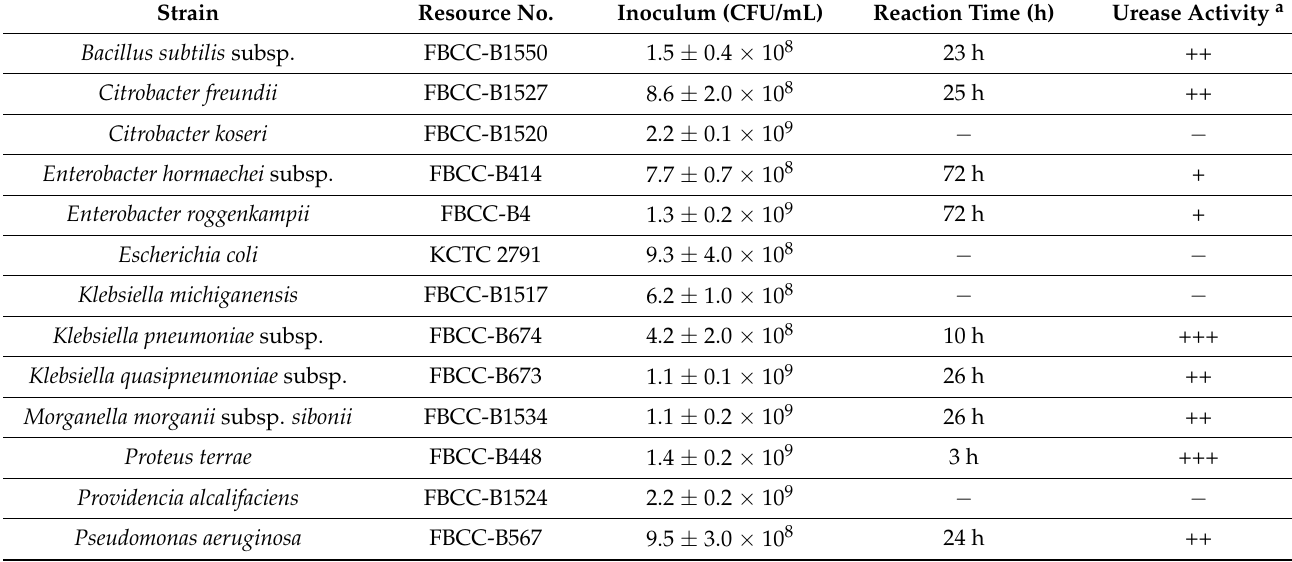
Table 1. List of microbes used for the detection of urease